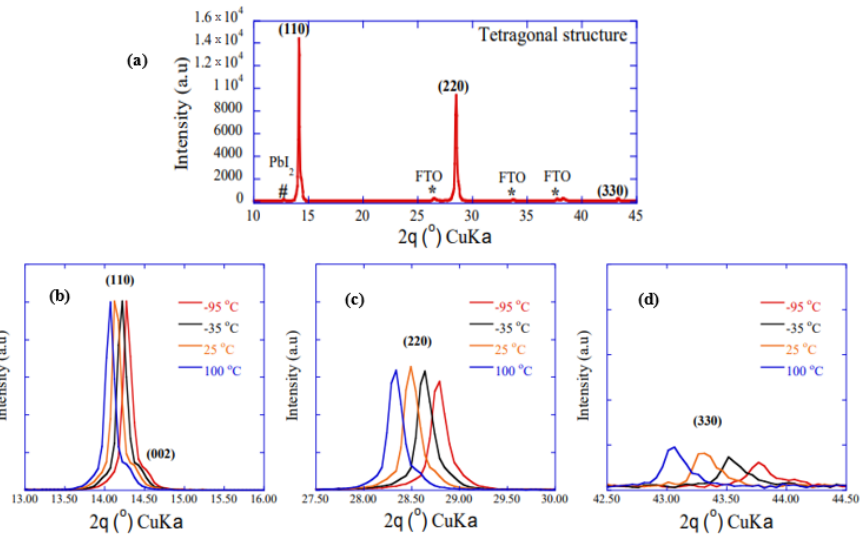
Figure 13. X-ray diffraction pattern of a perovskite sample ( a ) heated at 25 °C, ( b – d ) magnified per- ovskite CH 3 NH 3 PbI 3 characteristic peaks heating at temperature range −9 5 °C to 100 °C [78].